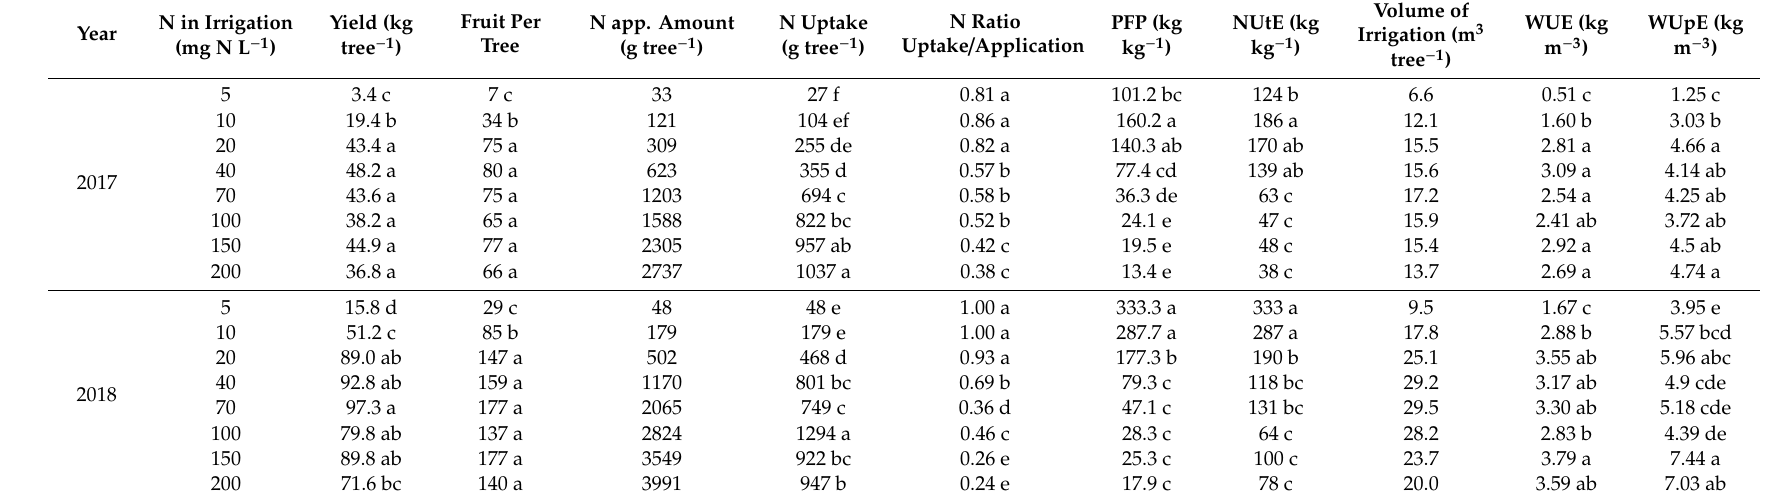
Table 2. Yield, nitrogen and water during 2017 and